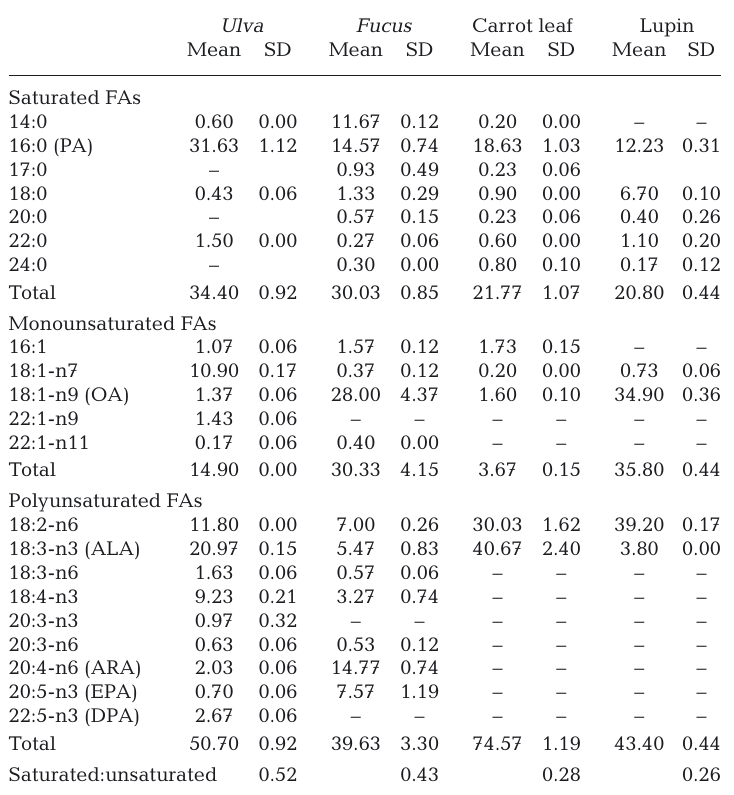
Table 2. Fatty acid (FA) composition (% of total FAs) of diets used in the feeding trials. PA: palmitic acid; OA: oleic acid; ALA: α -linolenic acid; ARA: